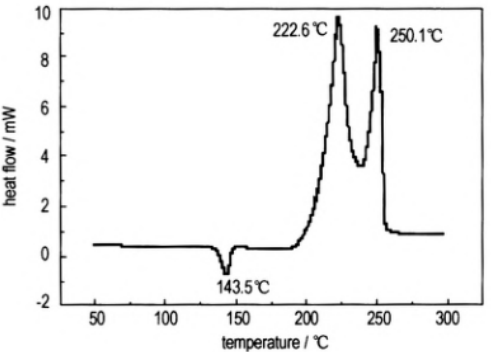
Figure 14. DSC curve of the CL-20/TNT cocrystal explosive [8], with permission from Han Neng Cai Liao, 2012.